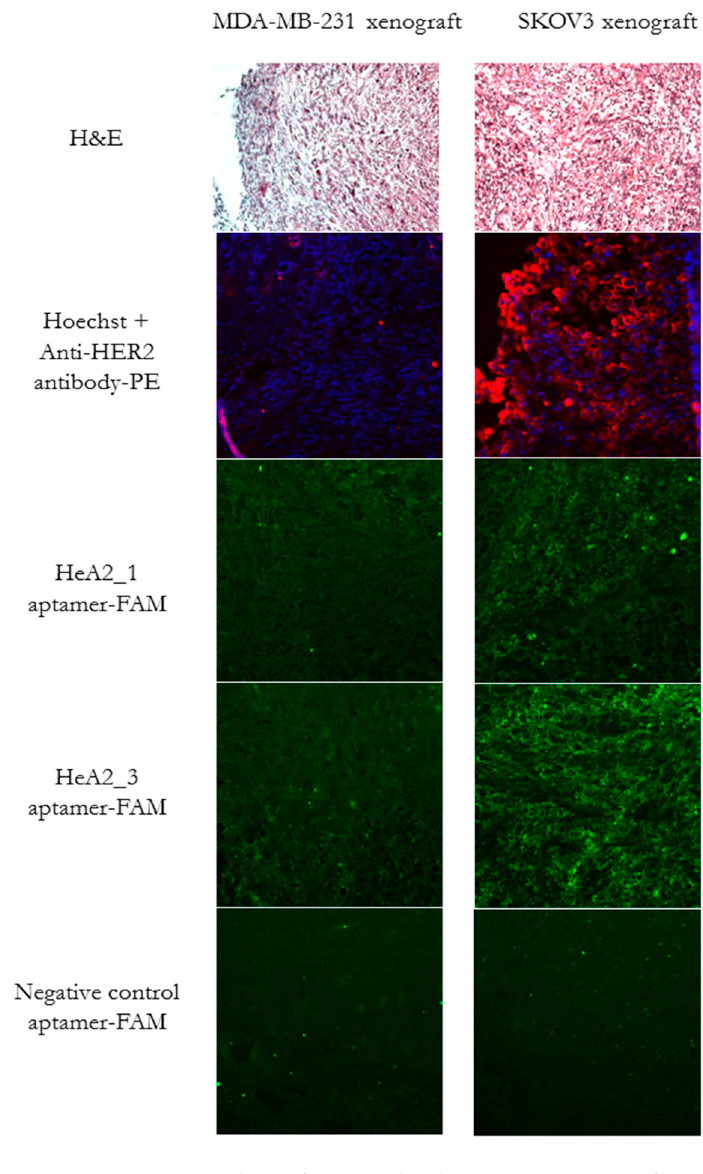
Figure 8. Fluorescence microscopy analysis of aptamer binding to tumor xenografts. Sections of tumor xenografts were stained with hematoxylin and eosin (top), Hoechst (blue) and the anti-HER2 antibody (red) or aptamer HeA2_1, HeA2_3 or the negative control aptamer (green). Images were taken at a magnification of 200×.